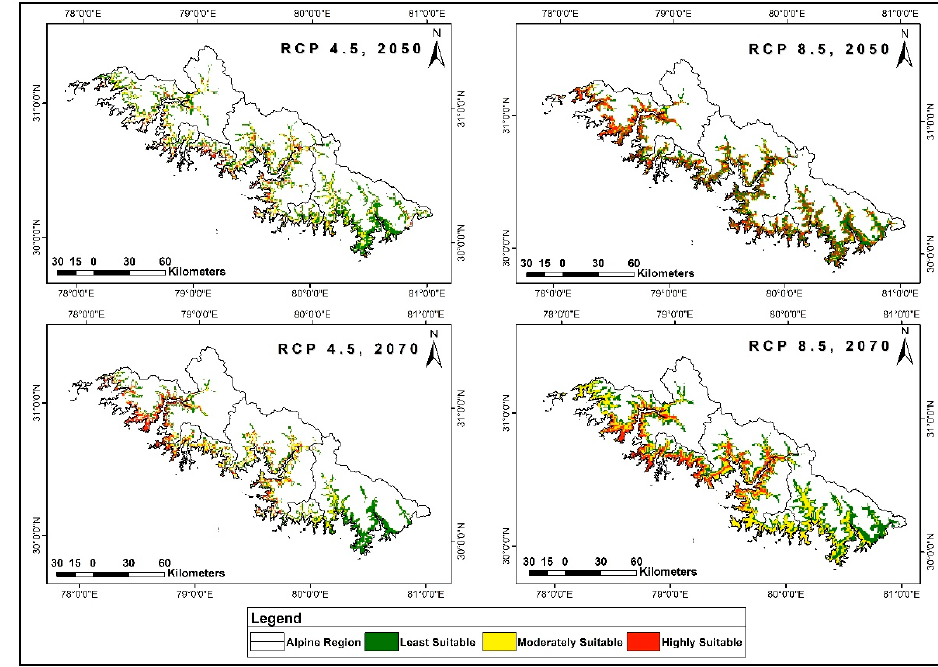
Figure 5. Predicted future habitat suitability for C. himalaicum. Table 3. Prediction accuracy of C. cordigerum under future climatic scenarios.